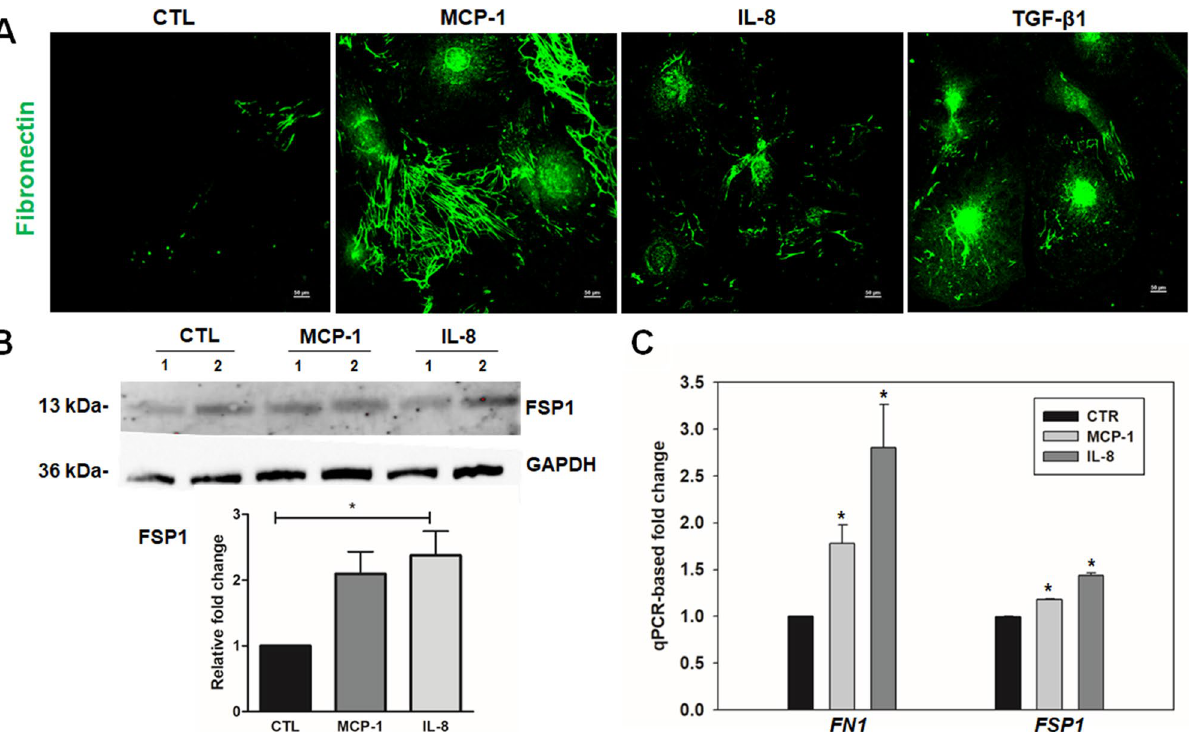
Figure 5. MCP-1 and IL-8 induces expression of fibrogenic and myofibroblast markers in human TM cells. Primary cultured TM cells we generated were serum starved, and treated with MCP-1 (100 ng/ml) or IL-8 (100 ng/ml) for 48 h or TGF-β1 (10 ng/ml) for 24 h before staining for fibronectin ( A ). Representative confocal images of stained cells show an increase in fibronectin (green) staining with MCP-1, IL-8, and TGF-β 1 treatment in immunoblotting and densitometric analyses ( B ). Treatment with MCP-1 and IL-8 also significantly increased the level of fibroblast specific protein (FSP)1 compared with the control group based on immunoblotting and densitometric analyses ( B ). The immunoblot data were normalized to GAPDH. ( C ) Semi-quantitative RT-PCR analysis of the same samples described in part ( A ) shows relative increase in the expression of fibrogenic genes ( FN1 and FSP1 ) in MCP-1 and IL-8 treated TM cells compared with the controls. Full-length blots/gels are presented in Supplementary Figure S4. Values are mean ± SEM and one-way ANOVA with Dunnett’s multiple comparison was done. * P < 0.05, N =